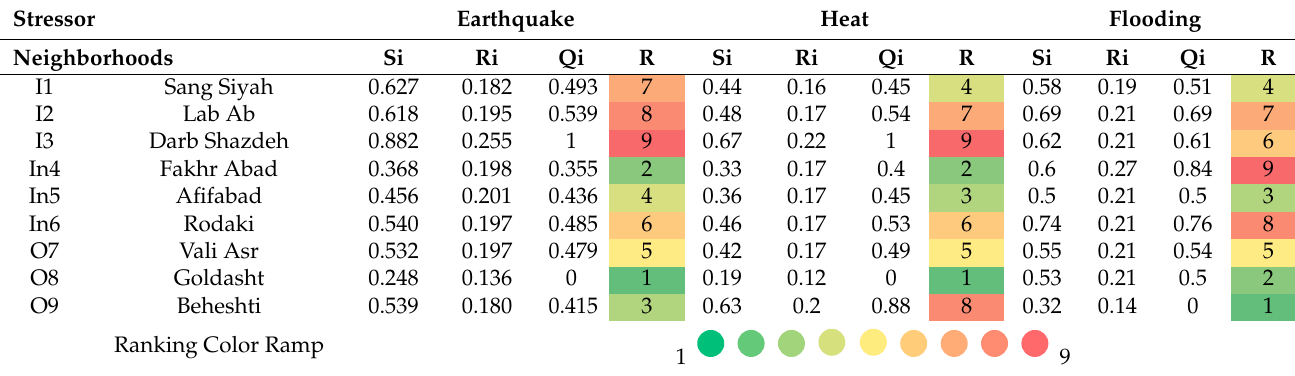
Table 5. Neighborhood ranking in against different risks (note that darker green and darker red indicate higher and lower rankings, respectively).